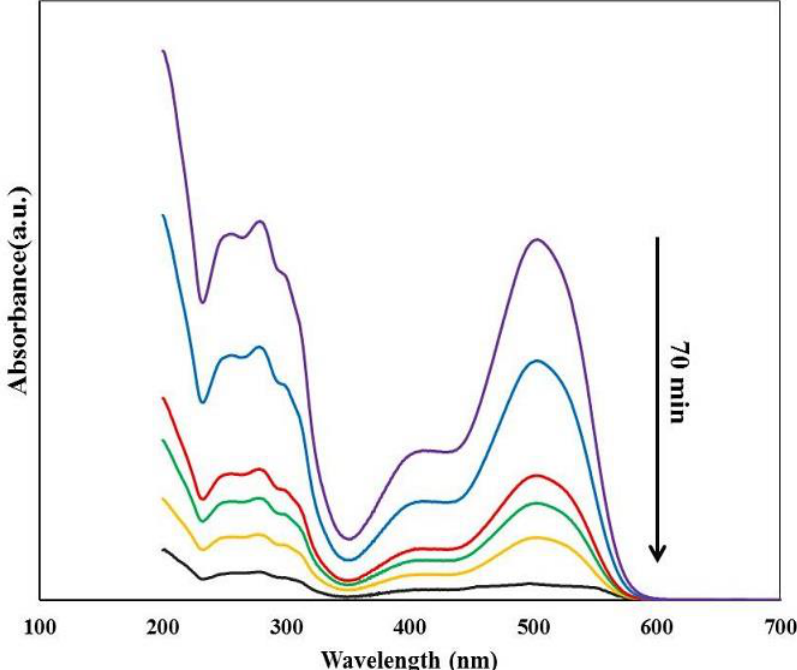
Figure 11. Degradation of Reactive blue 19 under ultrasonic irradiation using diatomite coated with 6% Dy-doped yttrium oxide